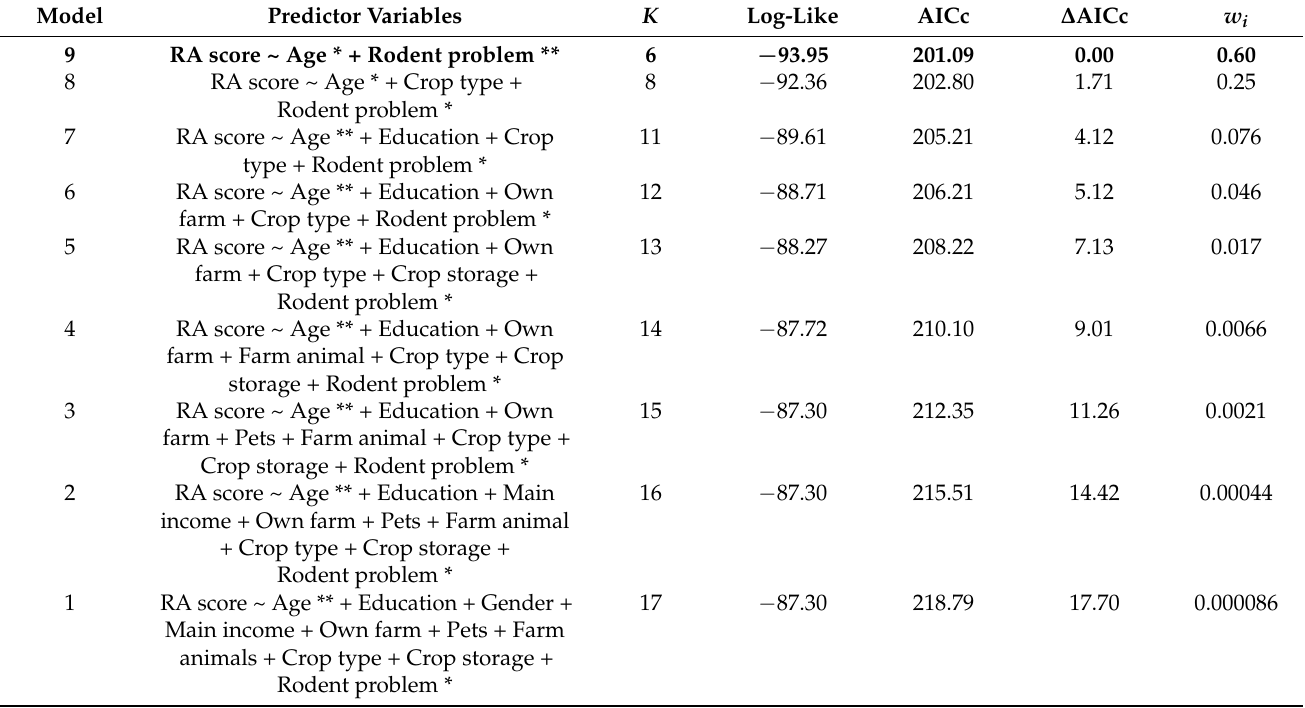
Table 3. Model outcomes of generalized linear models (GLM with linear function) by testing predictor variables (sociodemographic and farming-related variables) on rodent attitude (RA) score . The final model is indicated in